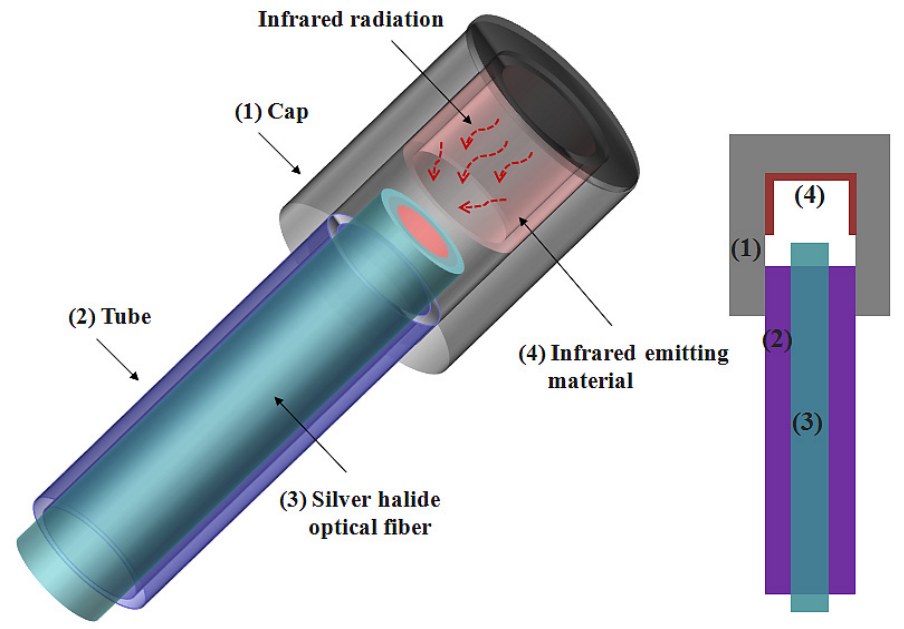
Figure 3. Structure of the temperature sensing